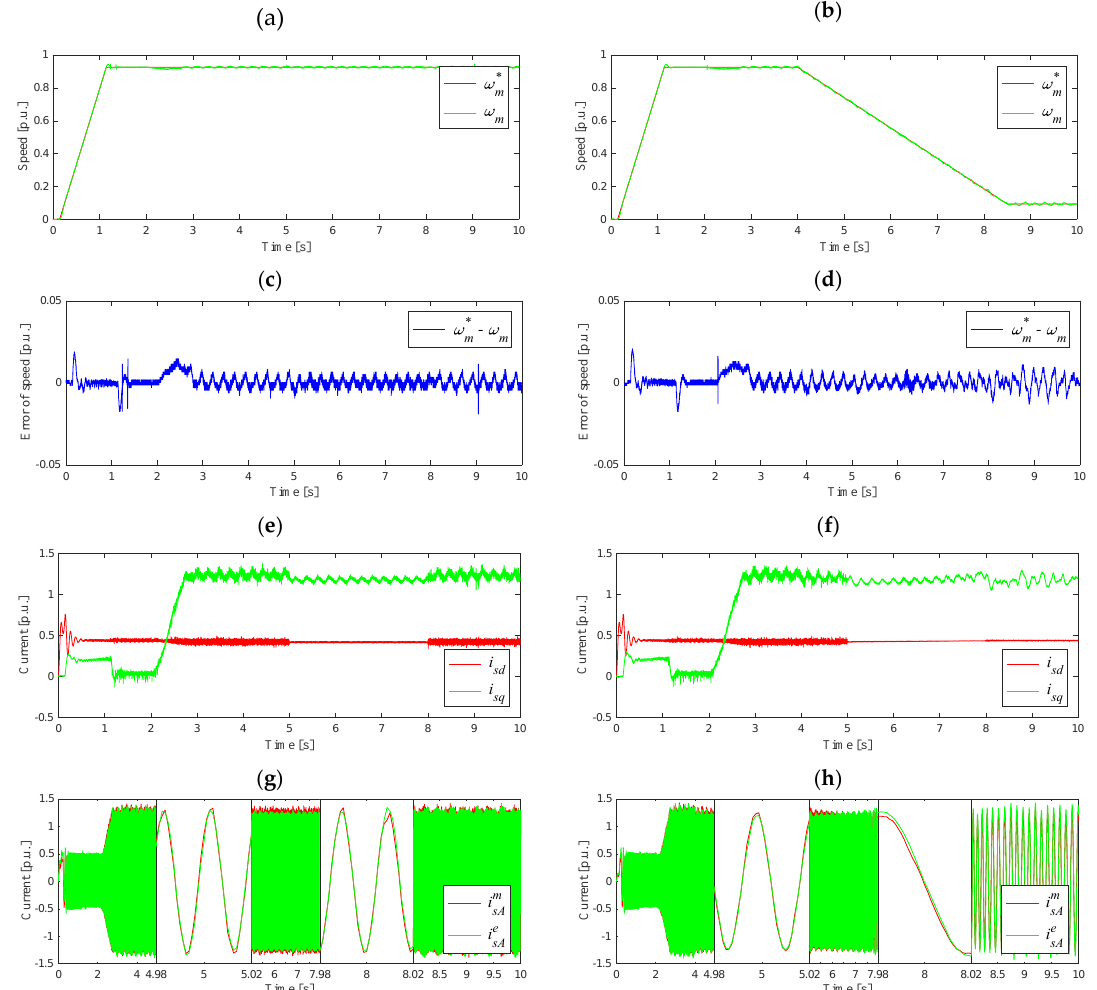
Figure 10. Waveforms of the motor variables under operation mode switching (time t = 5 s, switch P changes position from 1 to 2; time t = 8 s, switch P changes position from 2 to 1) for constant motor speed ( a , c , e , g ) and under speed decreasing ( b , d , f , h ): ( a , b ) reference and measured speeds; ( c , d ) speed error; ( e , f ) components of stator current vector; ( g , h ) stator current in phase A (with zooms).